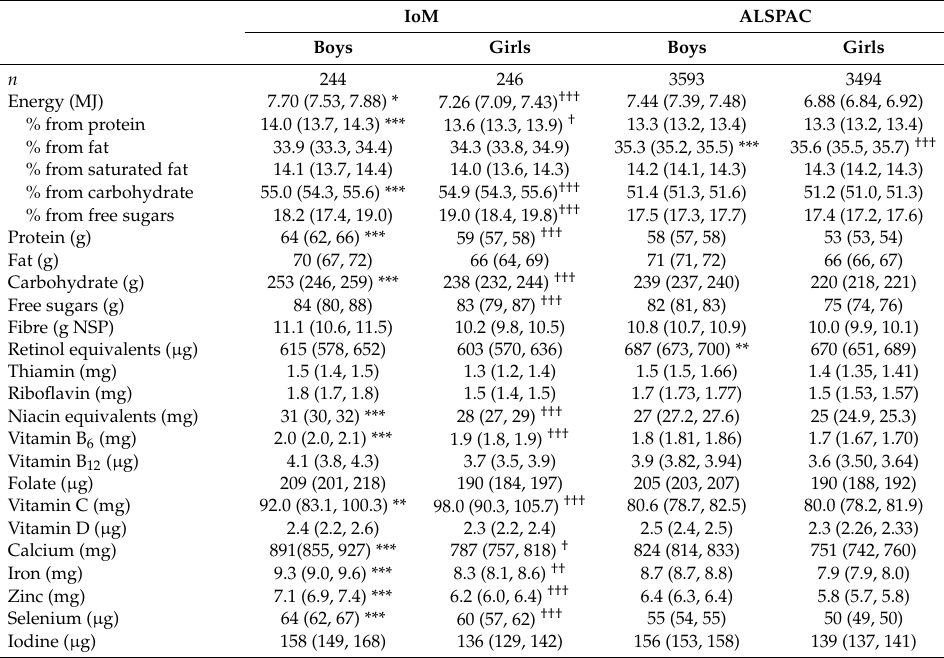
Table 2. Energy and nutrient intakes from 3-day food records in 7-year-old children: comparison between IoM and ALSPAC by sex.